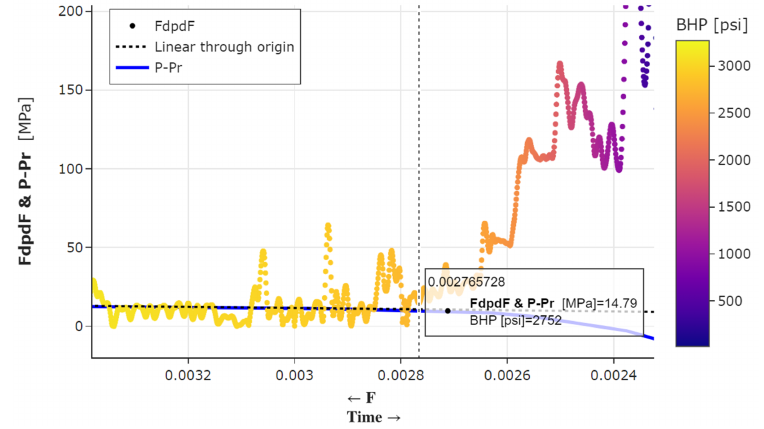
Figure 17. F-function of the flowback cycle 2.2. Table 6. Summary of analysis results of cycle 2.2.